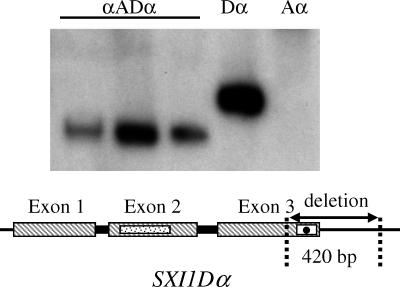
The SXI1Dα Gene Bears a C-Terminal Deletion in the αADα HybridsGenomic DNA of environmental isolates 5–19, 6–20, and 42–10, and reference strains JEC21 (Dα) and H99 (Aα), was digested with NcoI and probed with the SXI1Dα ORF (above). Weak cross-hybridization to SXI1Aα at higher molecular weight in AD hybrids and the serotype A control strain, but not in the serotype D control strain, is not shown here. Structure of the truncated allele of the SXI1Dα gene in the three environmental isolates 5–19, 6–20, and 42–10 (below). The black line indicates other genomic DNA, boxes with diagonal lines indicate exons, thick black lines indicate introns, the box with dots indicates the homeodomain, and dashed lines mark the 420-bp deletion in the C-terminus of the ORF (exon 3) and part of the 3′ untranslated region. The open box indicates the location of the SXI1Dα oligomer on the array. The dot inside the open box indicates the location of primer JOHE15636 used to amplify the SXI1Dα gene in the PCR screening.